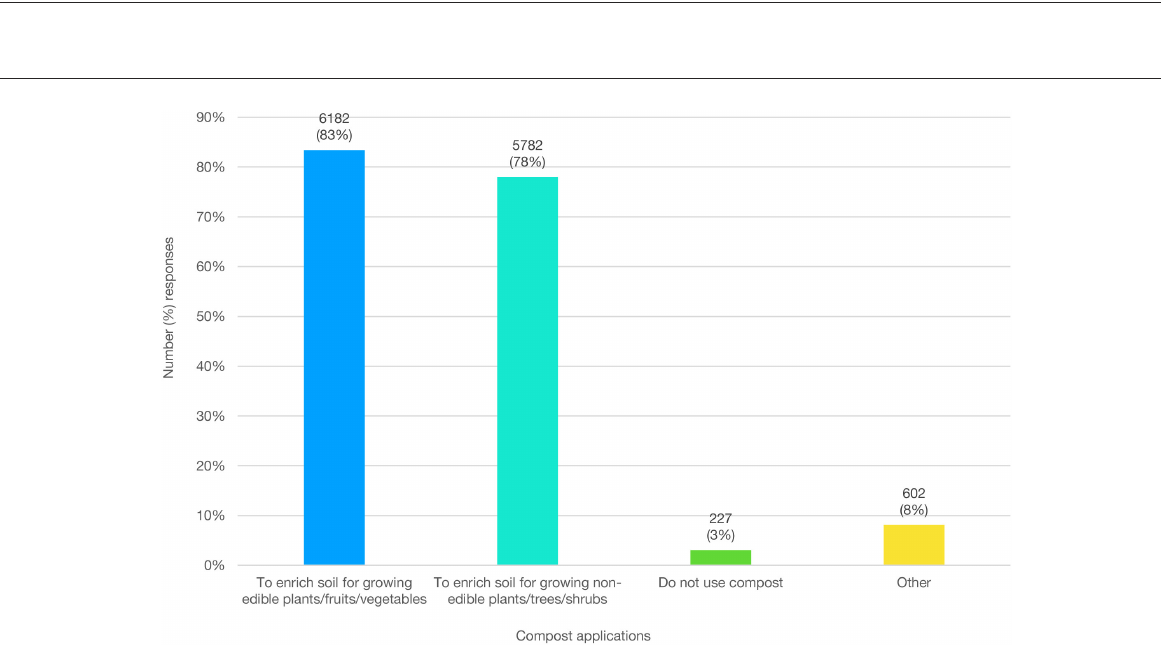
FIGURE5 Chart showing the range of compost applications used by survey participants. Values calculated from 7,413 participants who home compost. Multiple responses